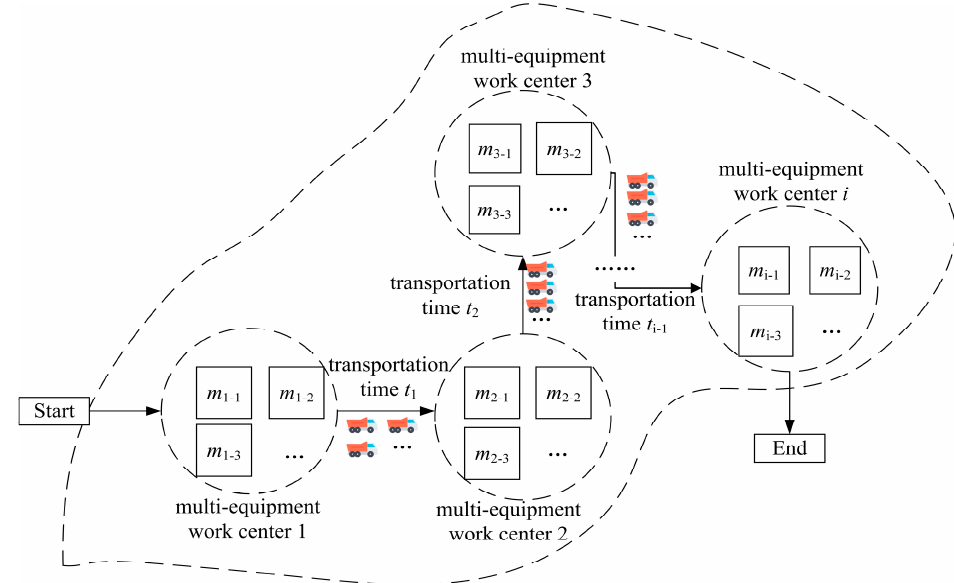
Figure 2. Diagram of a multi-equipment work center.